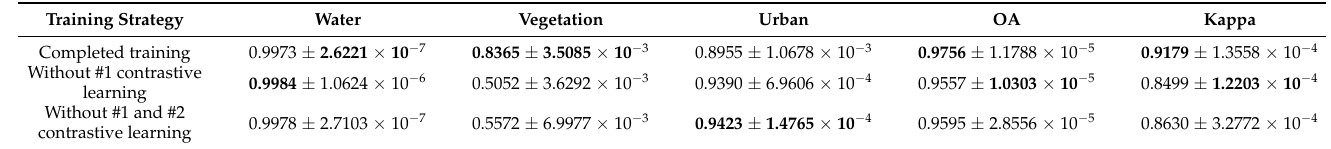
Table 8. Classification Results of Flevoland by using different training strategies, where the highest mean and lowest variance for each category are marked in